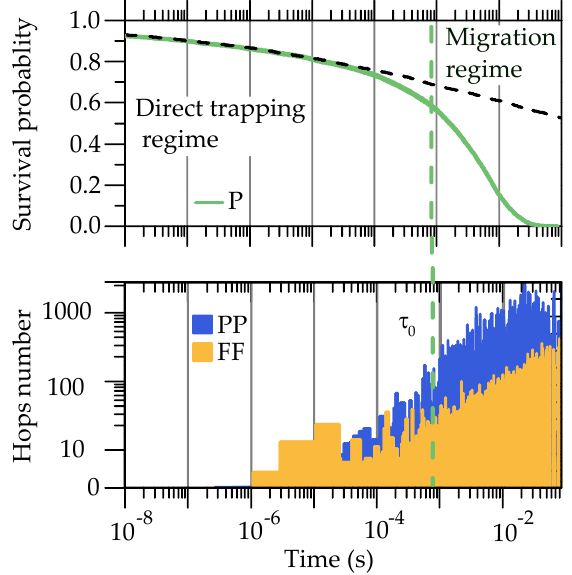
Figure 2. ( Top ) Survival probability of P polarons as measured by a typical LIA experiment. The black dashed line shows the decay shape when polaron migration is prohibited. The green dashed line is placed at τ 0 = 8 × 10 − 4 s, as calculated from Equation (12). ( Bottom ) Number of PP and FF hopping processes performed by each polaron during its